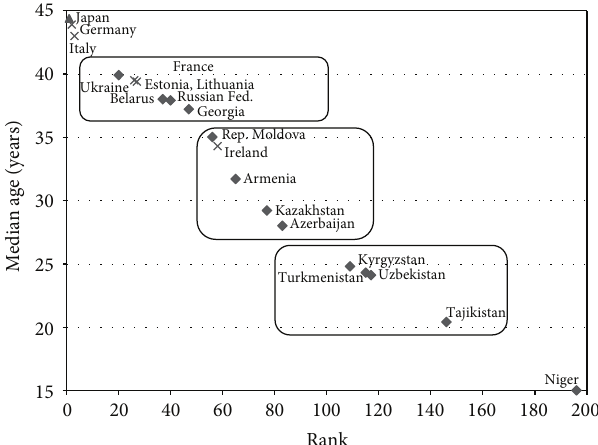
F 2: Ranking CIS countries by median age of population, 2009 (source: [15]).